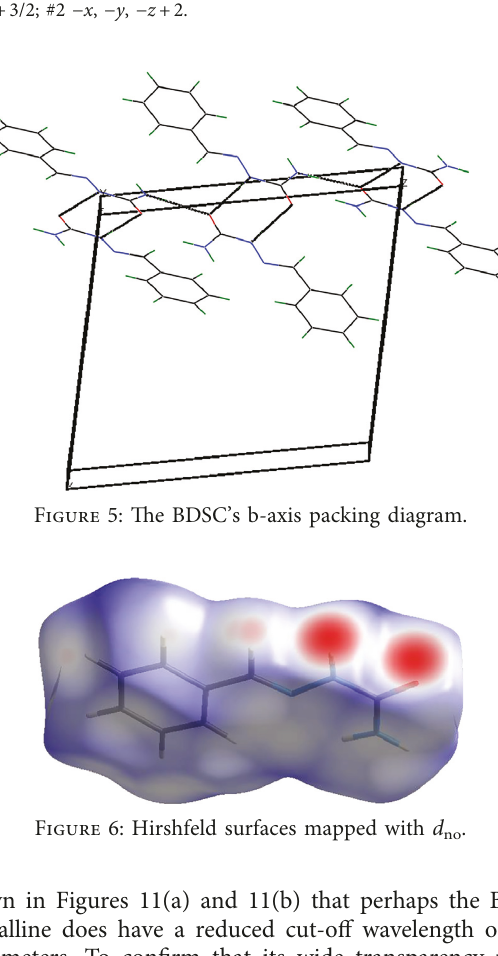
Table 3: Bond angles in BDSC crystals: comparison of measured and computed values.